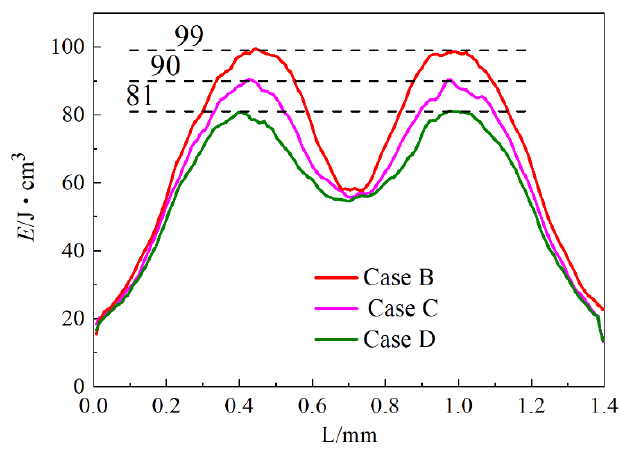
Figure 16. Effect of vessel cross section on energy deposition in the axis of the deep blood vessel at H cshad = 150 μm and α 0 = 30°. H cshad = 150 µ m and α 0 = 30 ◦